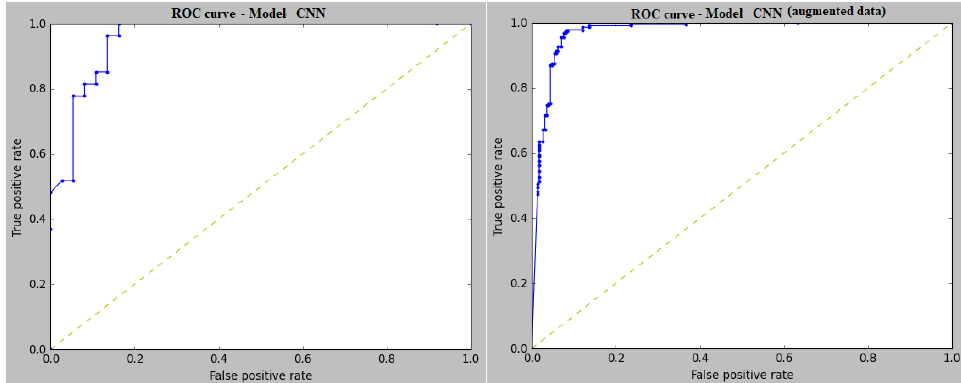
Figure 13. ROC curve of convolutional neural network (CNN) models.